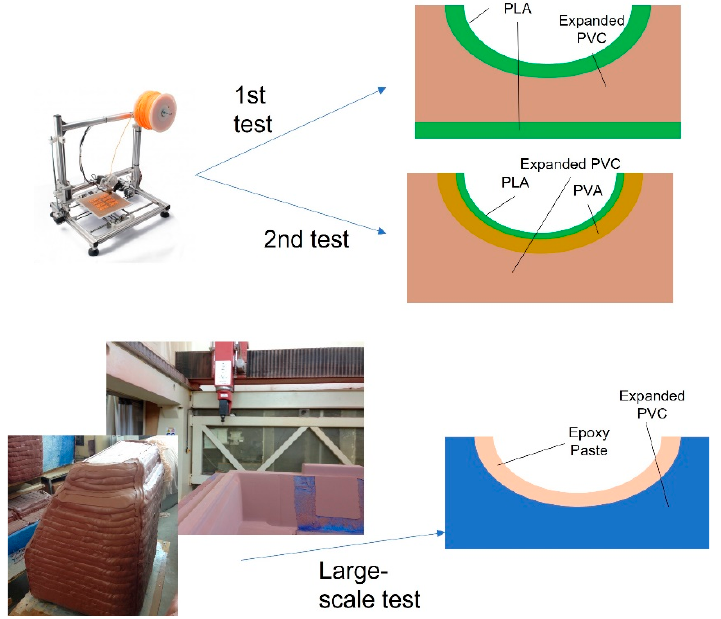
Figure 7. Schematic representation of the tests used to validate the proposed methodology for desktop and large-scale hybrid manufacturing